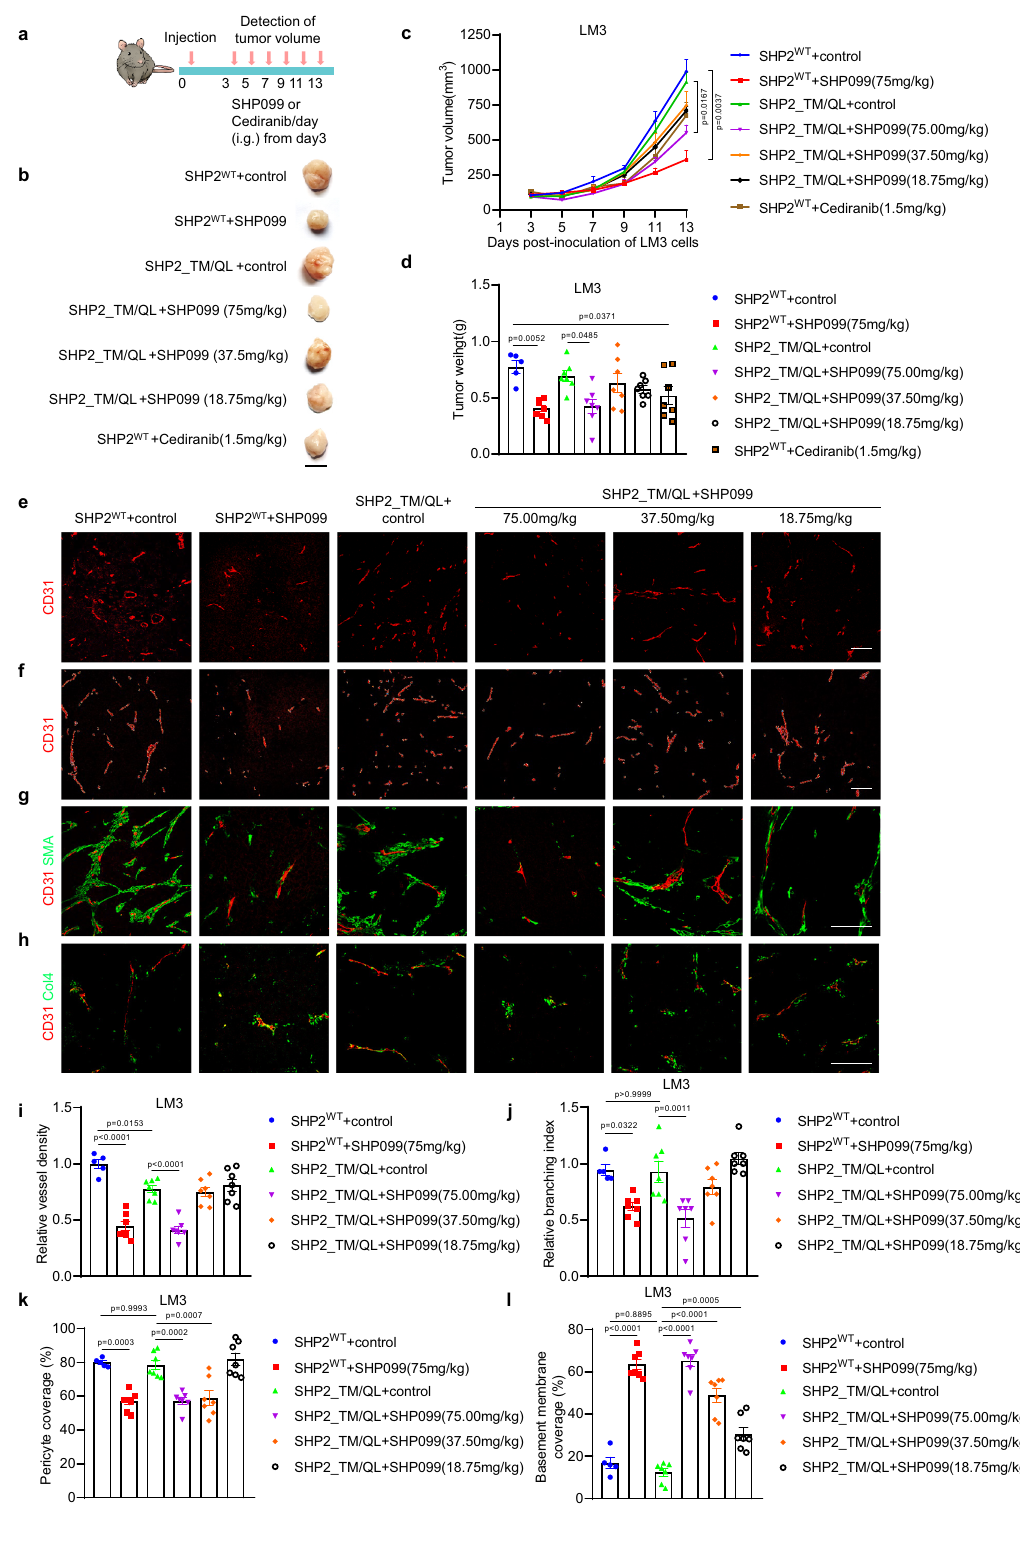
SOX7 expression in endothelial cells is controlled by